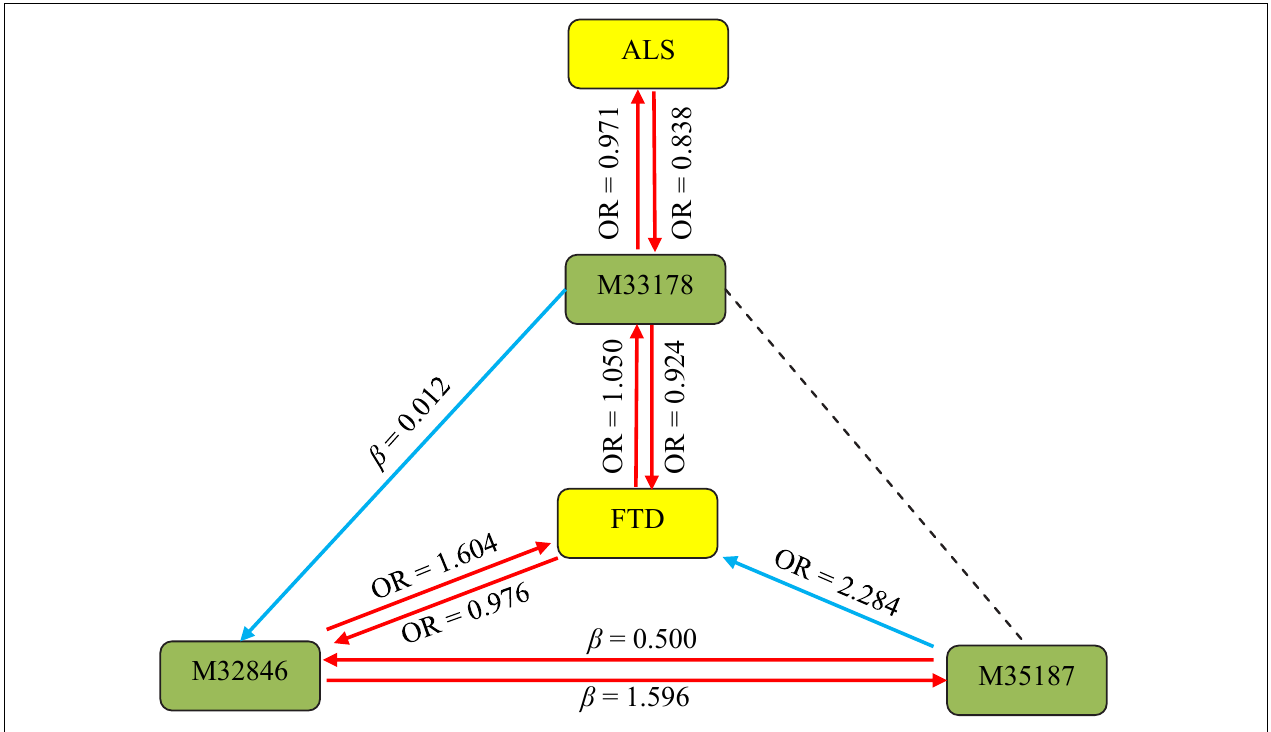
FIGURE 3 | Association pathways between three metabolites and ALS/FTD with MR analysis. M33178: 2-methoxyacetaminophen sulfate; M32846: X-11529; M35187: X-13429; ALS: amyotrophic lateral sclerosis; FTD: frontotemporal dementia. The solid arrow stands for the presence of the association, while the dot line represents the absence of the